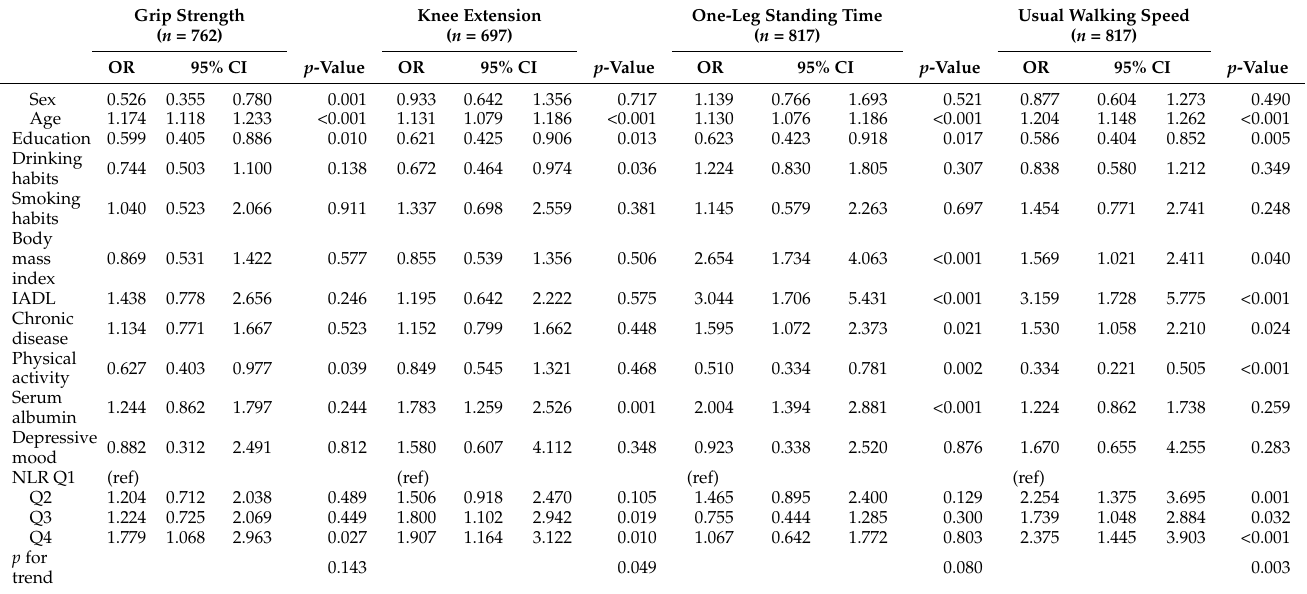
Table 3. Associations between NLR and physical